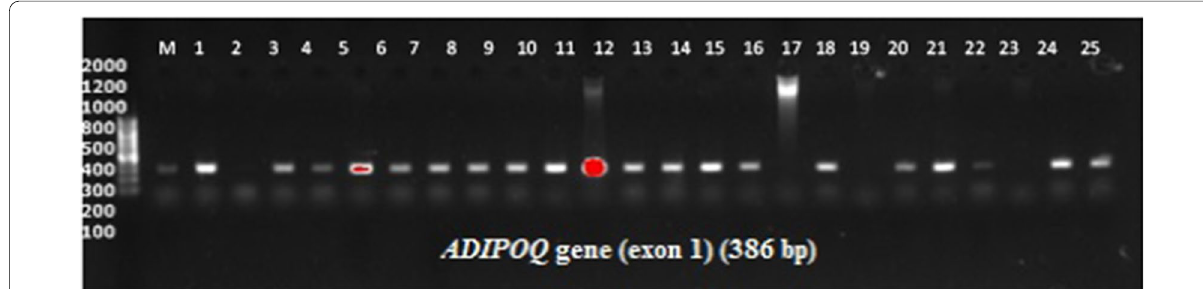
Fig. 1 Agarose gel electrophoresis for PCR products amplification of the ADIPOQ gene. Lane M: 100 bp DNA ladder; lanes 1–25 indicate samples of ewes. Electrophoresis conditions: 1.5% agarose concentration, electrophoresis time 25 min. The buffer used TBE pH 8.3